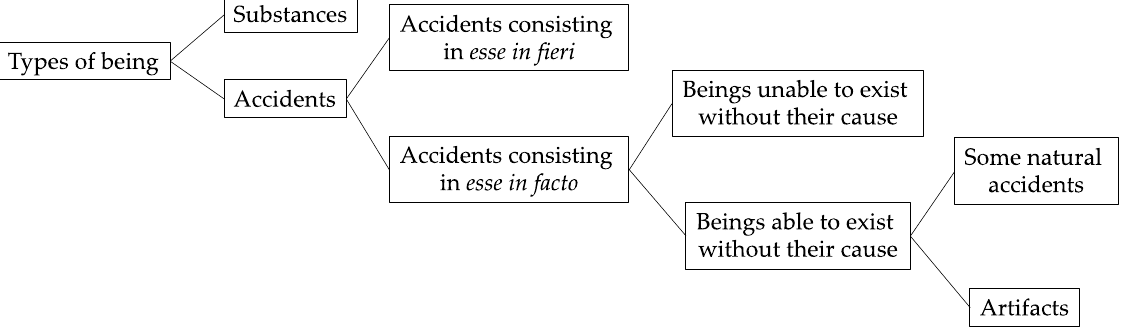
Figure 3. Types of beings and classification of artifacts according to Zabarella.